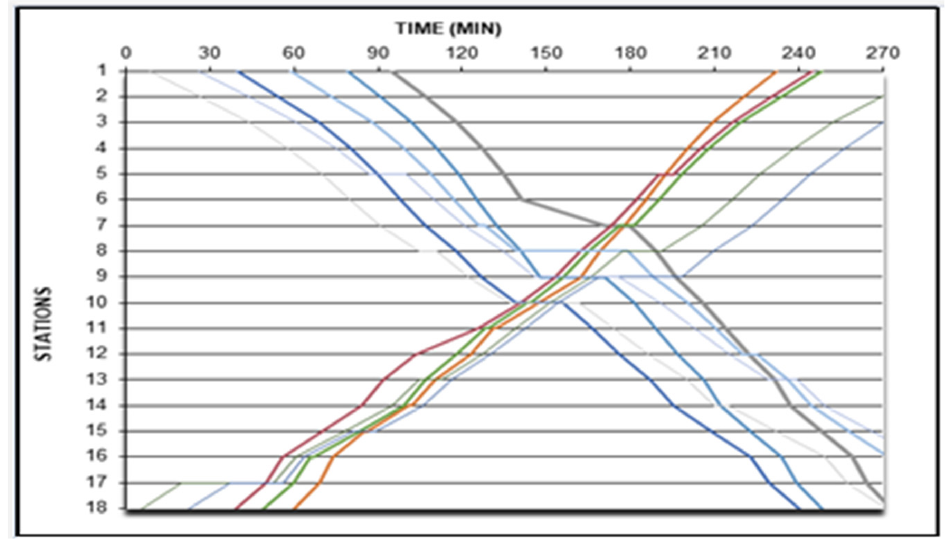
Figure 6. Final solution of Instance 1.